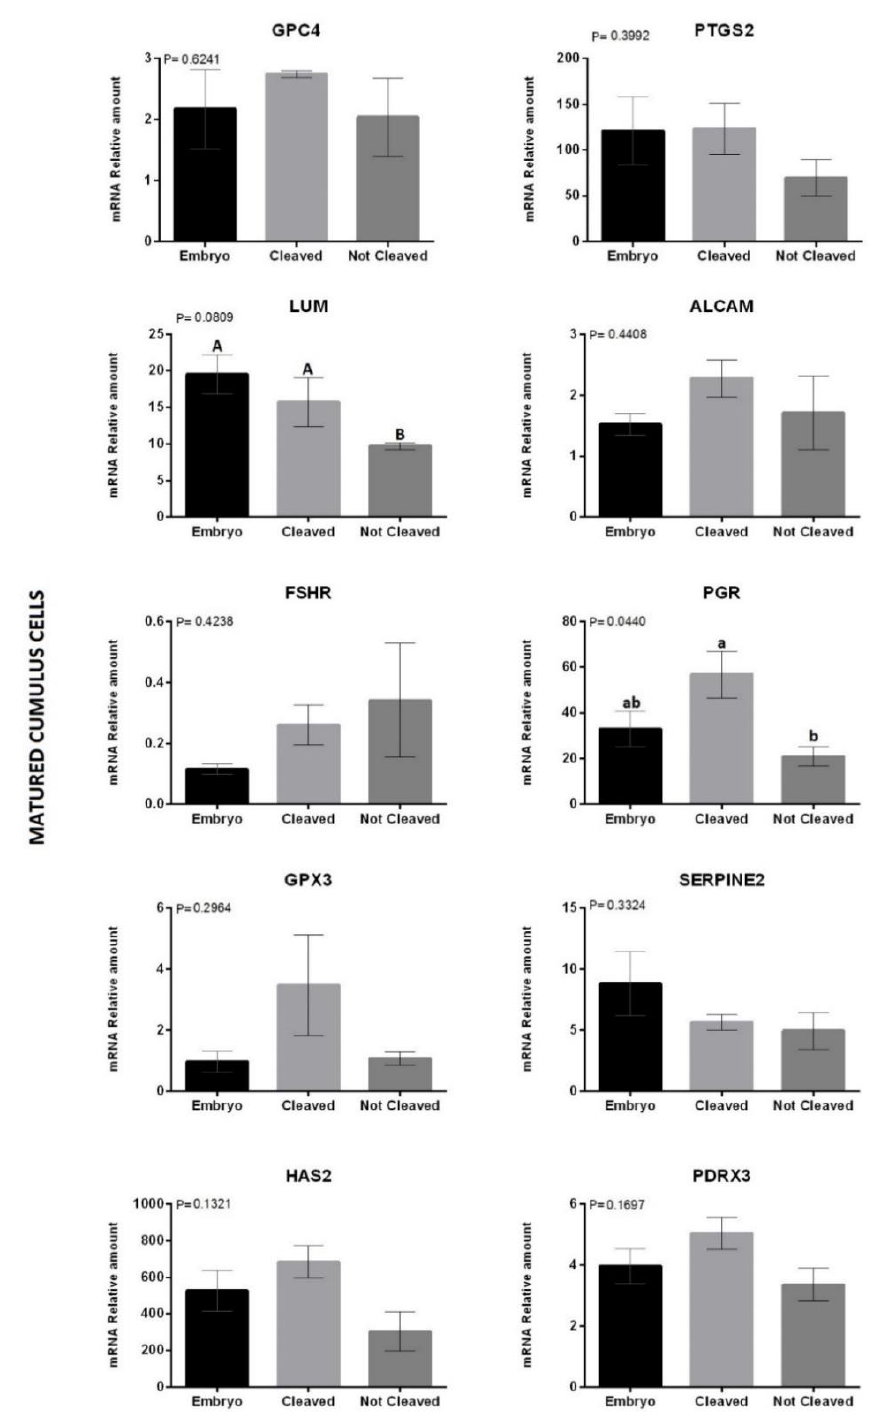
were normalized using the formula DDCT by Pfaffl [46], with GAPDH as an endogenous control. 0.05, according to the T test.